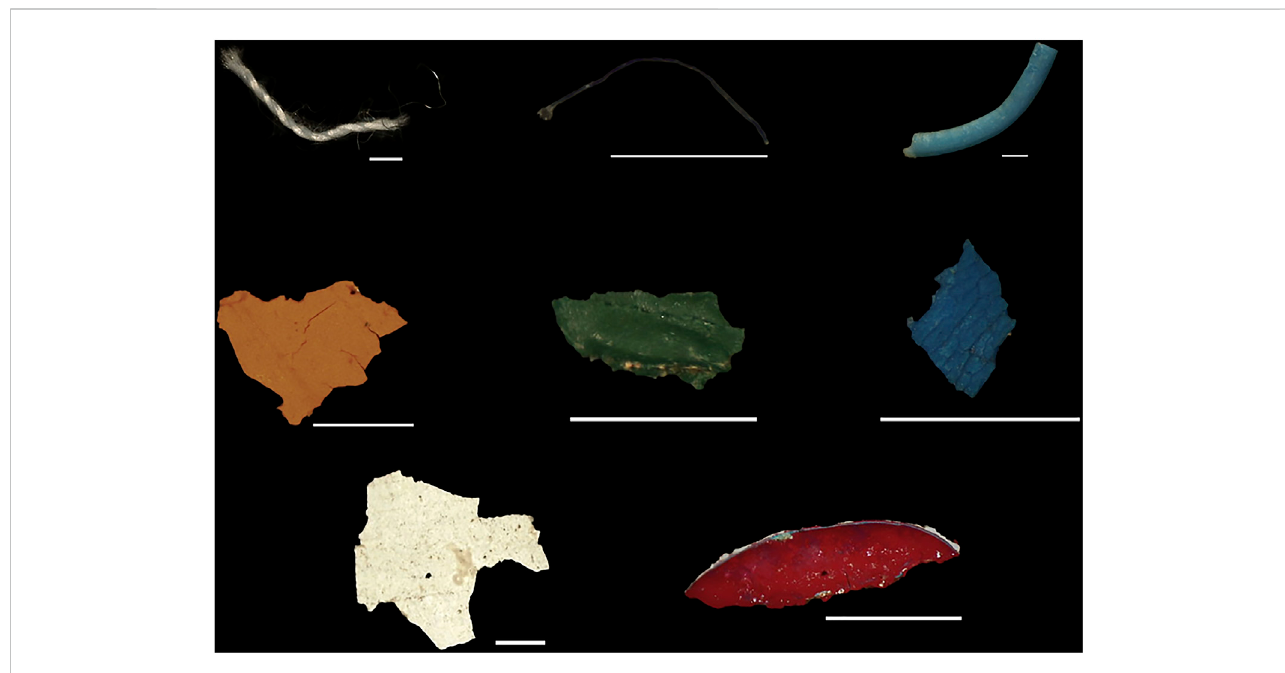
Some classi fi cations of plastic waste captured in different hydrological phases and sectors of the Tapajós River, Amazon Basin,